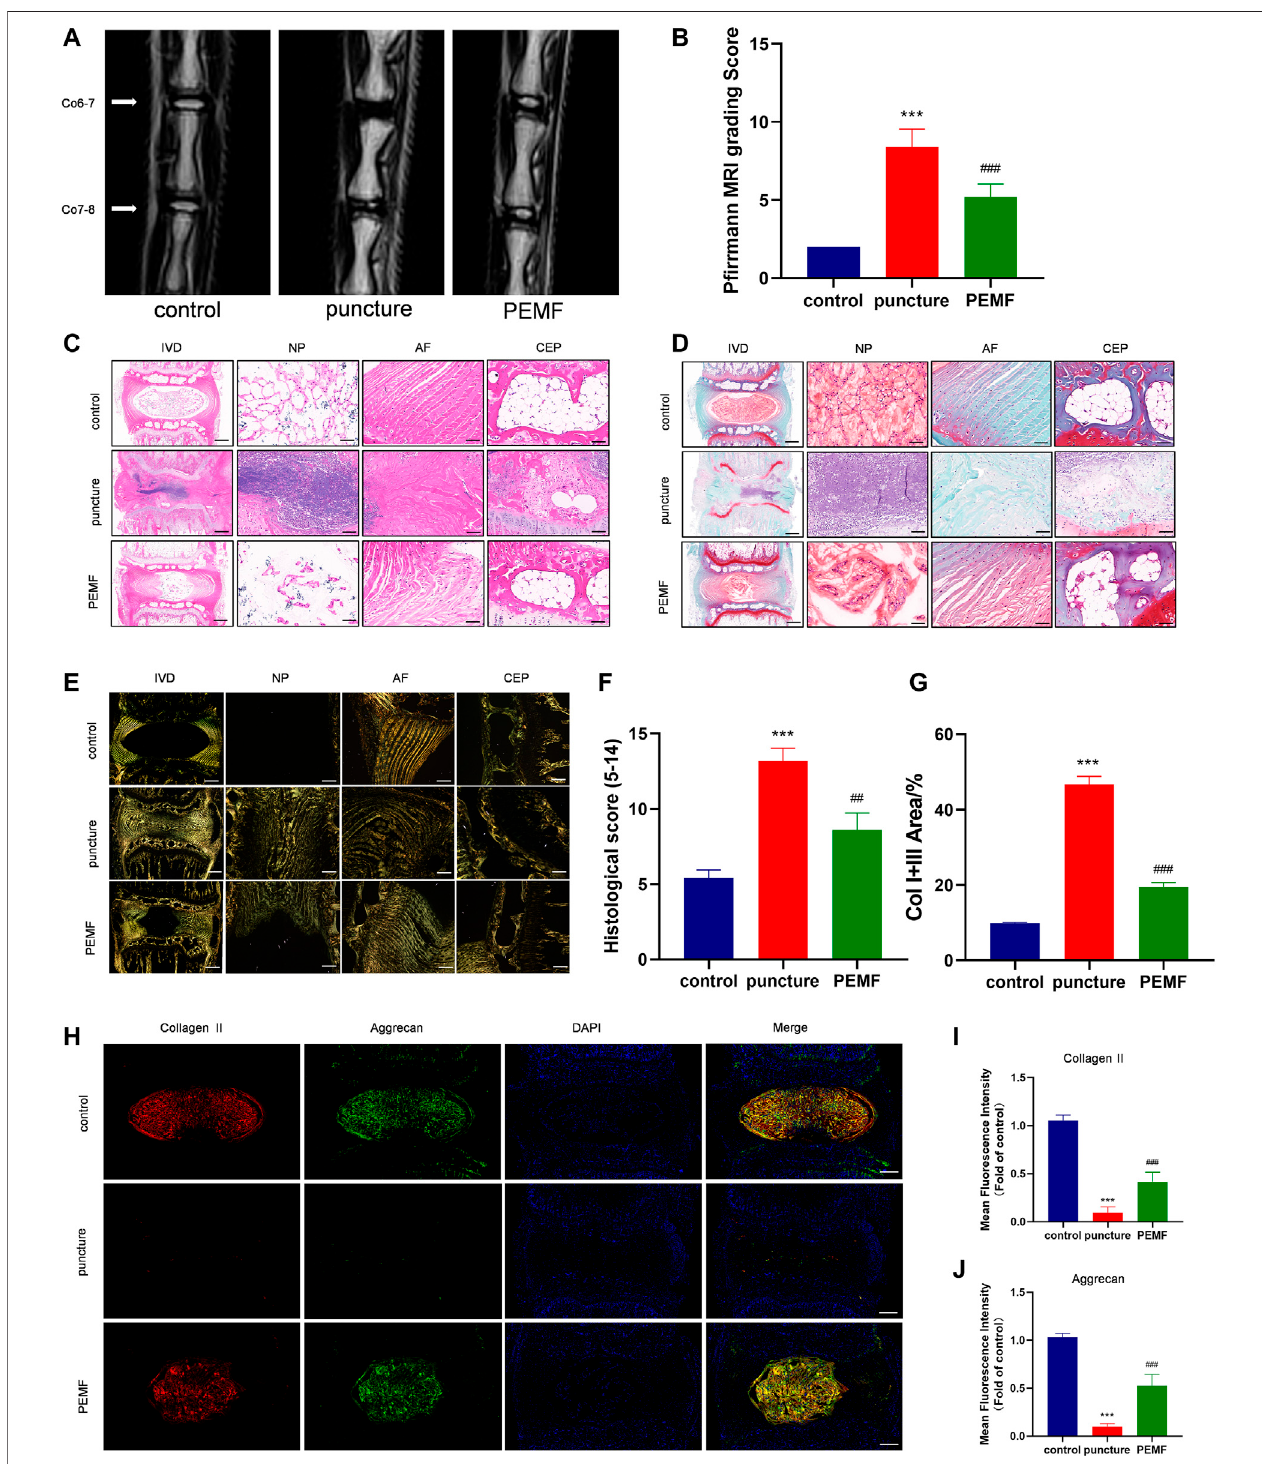
FIGURE 6 | PEMF exposure improved rat IVD degeneration in vivo . (A – B) Representative images of IVD tissue MRI and Pf fi rrmann score after 8 weeks of PEMF exposure. (C – E) Representative images of IVD tissue HE, S-O staining, and Polarized Sirius Red image (level: Co6-7; sagittal; scale bar: 500 µm, 100 µm). (F – G) Corresponding histological score and percentage of type I and type III collagen area. (H – J) Representative images of immuno fl uorescence and semi-quantitative analyses of Collagen II and Aggrecan fl uorescence intensity in IVD tissues, imaged by fl uorescence microscopy (sagittal; scale bar = 500 μ m). *** p < 0.001 vs. control, ## p < 0.01 vs. puncture, ### p < 0.001 vs. puncture. Data expressed as means ± SD.